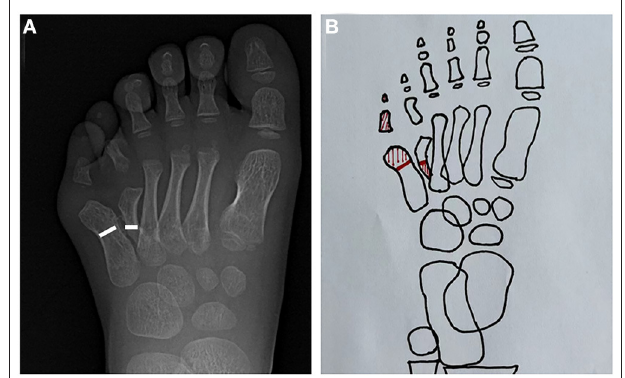
FIGURE 2 | Radiographic and schematic depiction of the surgical process. (A) Radiographic image depicting the lateral column and medial column osteotomy line. (B) Schematic diagram of the surgical process. The red shaded part represents the excised part.